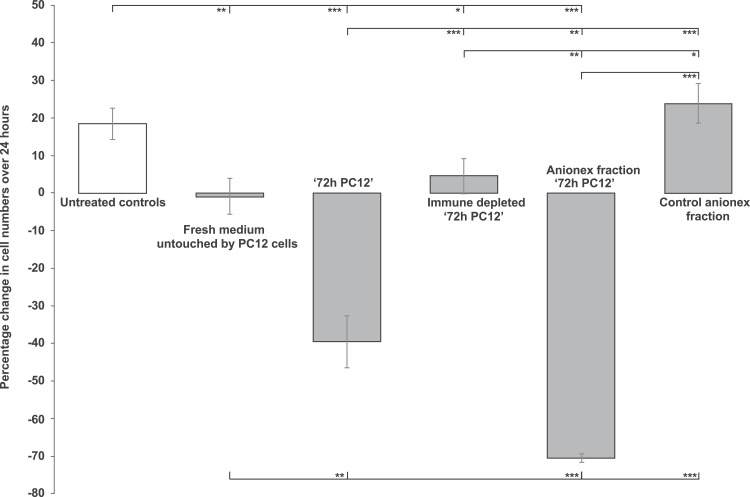
Rat bone marrow cells in culture exposed to PC12-conditioned medium in different forms.The medium was provided neat, immunodepleted (using an anti-EPL001 antibody) and subjected to anion exchange chromatography. Data are mean ± SEM; four replicates per group. Students t-test: * = P < 0.05, ** = P < 0.005, *** = P < 0.001.